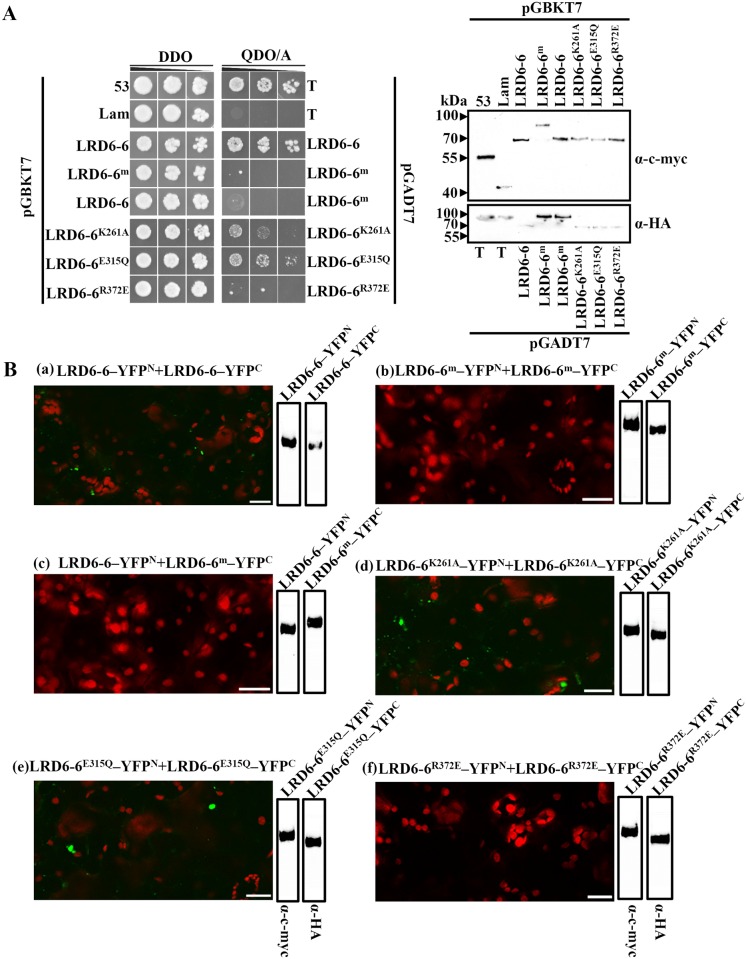
Dimerization of LRD6-6 in yeast and in planta.(A) Dimerization test of the LRD6-6 in yeast. The full-length CDSs for LRD6-6, the mutant lrd6-6 (LRD6-6m) and the variants, LRD6-6K261A, LRD6-6E315Q and LRD6-6R372E were respectively inserted into the pGPBKT7 (BD) and pGADT7 (AD), and were subjected to Y2H test through co-transformation by pairs (left panel). The pairs, pGBKT7-53/pGADT7-T and pGBKT7-Lam/pGADT7-T, representing positive and negative interactions, respectively, were also included in this test. The positive transformants were diluted in 10-fold serial dilution and spotted on double dropout medium (SD/–Leu/–Trp; DDO) and quadruple dropout medium supplemented with Aureobasidin A (SD/–Ade/–His/–Leu/–Trp/AbA; QDO/A) plates. The growth of co-transformed yeast cells in the medium QDO/A indicates protein–protein interaction in yeast. Western blot analysis with anti-c-myc or anti-HA antibodies was performed to ensure the expression of BD- and AD-fused proteins, respectively, for each co-transformation event (right panel). (B) BiFC analyses on the dimerization of LRD6-6 in N. benthamiana. The full-length CDSs for LRD6-6, the mutant lrd6-6 (LRD6-6m) and the variants, LRD6-6K261A, LRD6-6E315Q and LRD6-6R372E were respectively inserted into the split yellow fluorescence protein (YFP) vectors, split YFPN and split YFPC, and were co-transformed into N. benthamiana cell by pair. The punctate YFP signals represent interaction between the co-expressed proteins, while the red signals represent the auto-fluorescence of chlorophyll. The YFP signals didn’t overlap with the auto-fluorescence, bars = 20 μm. The expression of proteins was detected by anti-c-myc or anti-HA respectively.